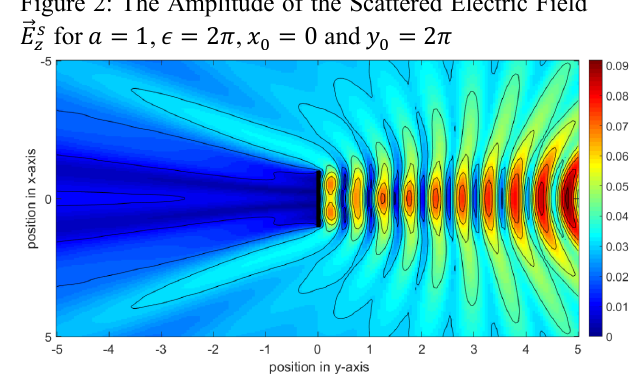
Figure 2: The Amplitude of the Scattered Electric Field 𝐸Q⃗ Ab for 𝑎 = 1 , 𝜖 = 2𝜋 , 𝑥